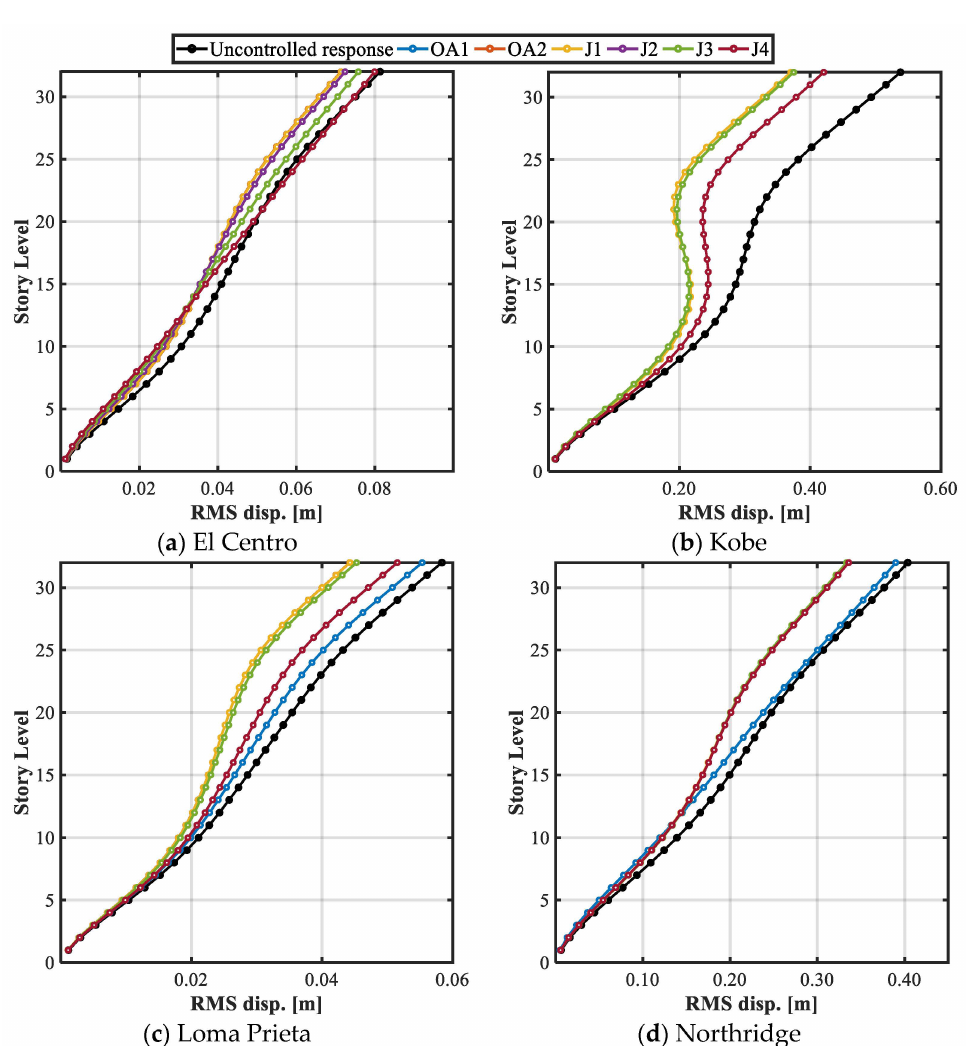
Figure 9. RMS displacement at each story level of the structure equipped with TMDs with µ =